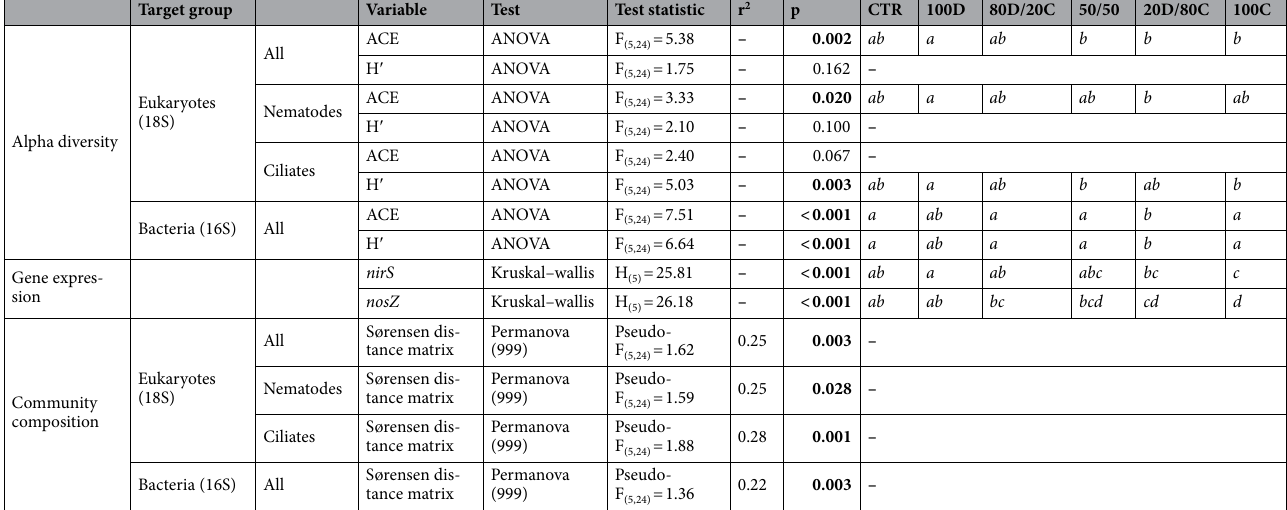
Table 1. Summary of statistical tests. Differences in alpha diversity indices (Abundance-based coverage estimator (ACE) and Shannon’s diversity index H ′ ) were tested with one-way ANOVAs for the microeukaryotes (18S rRNA) and bacteria (16S rRNA) datasets as well as nematodes and ciliates separately. Difference in transcript copy numbers for the denitrification genes nirS and nosZ were tested with Kruskal– Wallis. Differences in community composition were tested with PERMANOVAs on the microeukaryotes (18S rRNA) and bacteria (16S rRNA) datasets. Significant p-values (< 0.05) are indicated in bold. The treatment groupings based on post-hoc tests are displayed as letter codes on the right of the table. See Fig. 6 for treatment